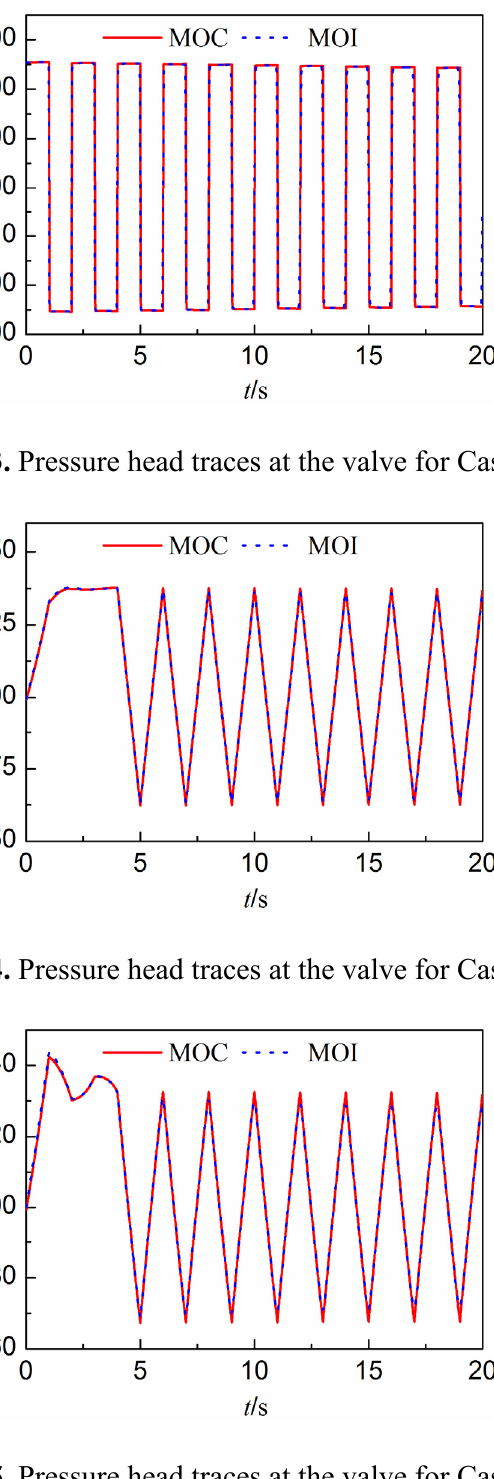
Figure 5. Pressure head traces at the valve for Case